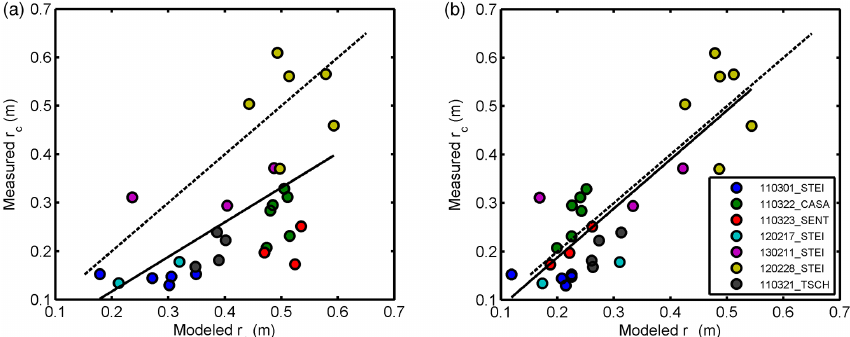
Figure 8. Critical crack lengths r c predicted from Eq. (7) are contrasted with critical crack lengths measured in the field ( N = 31). Experi- ments grouped by date and location with colors. Solid line shows linear regression, dashed line indicates the 1 : 1 line. (a) Slab stratigraphy neglected (average density, average effective modulus). (b) Density and effective modulus of each snow layer taken into account by FE simulation.